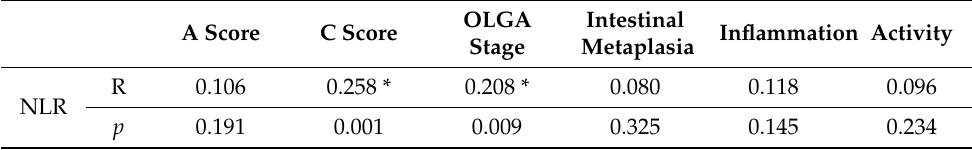
Table 2. Correlation analysis results between NLR and gastric parameters ( n = 155). OLGA Intestinal Inflammation Activity A Score C Score Stage Metaplasia R 0.106 0.258 * 0.208 * 0.080 0.118 0.096 NLR p 0.191 0.001 0.009 0.325 0.145 0.234